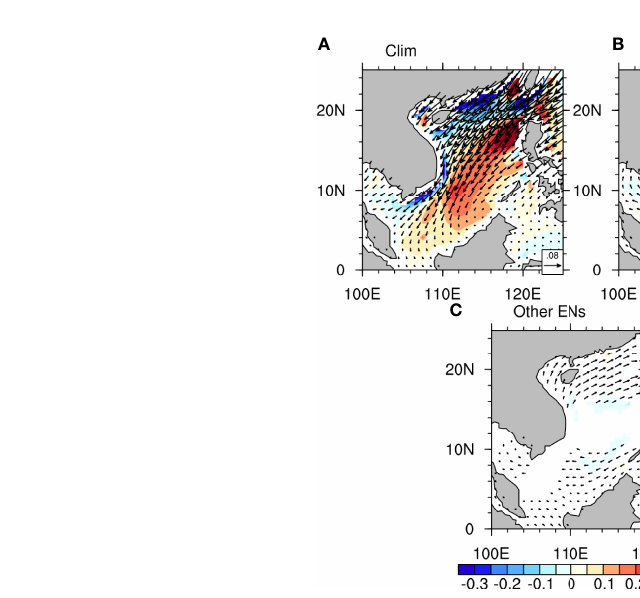
FIGURE 9 | (A) Climatological wind stress (vectors, unit: N/m 2 ) and wind stress curl (shading, unit: ×10 − 6 N/m 3 ) over OND(0). (B) Same as in (A) but for the wind stress and wind stress curl anomalies for super El Niño composite. (C) Same as in (B) but for other El Niño composite. Shaded areas and vectors in (B, C) are only shown for the results exceeding the 90% con fi dence level based on Student ’ s t -test.